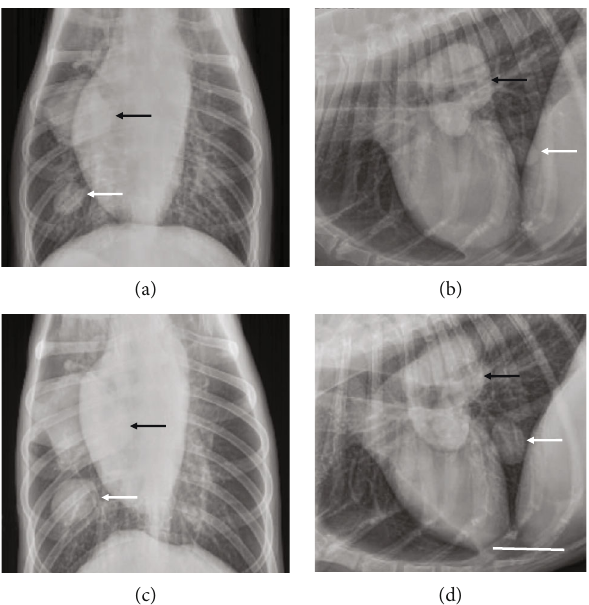
Figure 10: The chest X-rays in (a) and (b) depict the AP and RL appearance of 2 masses in the right lung prior to treatment with TOL. The larger mass (black arrows) is located centrally in the middle lobe in close proximity to the hilus of the lung and smaller mass (white arrows) is located more caudal in the cranial lobe. (c, d) The appearance of the same masses 7 months later after receiving 7 rounds of treatment with TOL. Taking account of the positioning in the X-ray machine, the size of the tumors varied but appeared to have increased gradually by approximately 28% over the 7 1/2 month course of treatment. The calibration bar in (d) is 2.5 μ m.